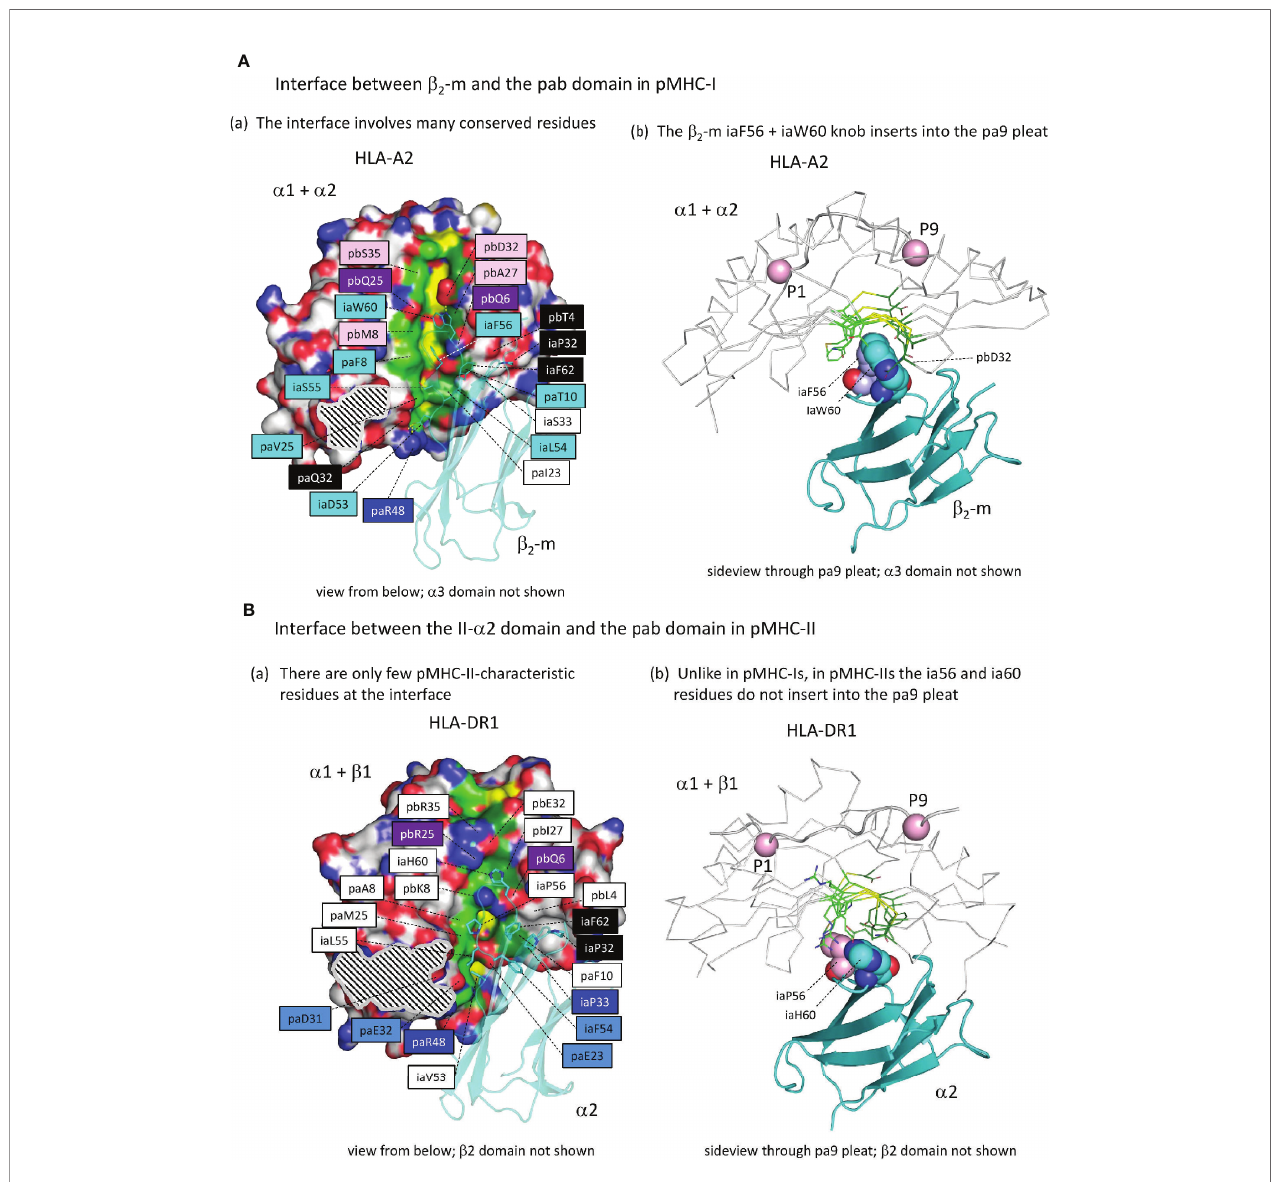
FIGURE 7 | The interface between the ia and pab domains is different between pMHC-I and pMHC-II. ( A a) The pMHC-I structures, here represented by pHLA-A2, have many conserved residues/features at the b 2 -m to a 1 a 2 interface (for a complete list of interface residues see Supplementary Files 2A, B ), especially at the pa9 pleat contact region. Also, a contact patch involving paT10 and pbQ6 (both part of the pa9 pleat) and pbT4 and b 2 -m ia33 (mostly iaP33) and iaF62 is relatively well conserved. Many of the indicated residue names are shaded with non-white colors, which are based on estimated conservation patterns and are also used in Figure 3 and Supplementary File 1A : black, inherited from the MHC homodimer ancestor; dark blue, ancestral to the I- a 1+ b 2 -m/II a lineage; purple, ancestral to the I- a 2+I- a 3/II b lineage; light blue, characteristic for the I- a 1+ b 2 -m lineage; pink, characteristic for the I- a 2+I- a 3 lineage. The a 1 a 2 domain is indicated in surface format with only yellow for pa9 pleat top ridge residues (the ability to see them in this fi gure is evidence of the pleat being open) and element coloring for the other a 1 a 2 domain residues with red, blue, and gold for O, N, and S atoms, respectively, dark and light green for the C atoms of the pa9 pleat pa8 and pa10 lower ridge residues, respectively, and white for the other C atoms. The b 2 -m domain is shown in cyan transparent cartoon format with sidechains of highlighted residues in element color sticks format. The black and white striped region is the a 1 a 2 domain with a 3 domain contact region. Residue pbS35 does not directly contact b 2 -m but pa(A/S/T)45 is a conserved part of the constellation. (A b) The b 2 -m iaF56 + iaW60 residues (shown in individual, element color spheres format) insert into the pa9 pleat, which can easily be seen from this angle with the a 1 a 2 domain [coloring as in (A) ] shown in ribbon format and the sidechains of the pa9 pleat pa8 and pa10 lower ridges in sticks format. The peptide ligand is shown in cartoon format with the C a ’ s of P1 and P9 as pink spheres. ( B a) Similar fi gure as ( A a), but with pHLA-DR1 as a representative structure for pMHC-II. For interactions between the a 1 b 1 and a 2 domains, also see Supplementary Files 2A, B . Coloring of residue names is based on conservation patterns as also done in Figure 3 and Supplementary File 1A , and is similar as done in ( A a) except that MHC-II a -characteristic residues are colored non-dark blue. ( B b) is as ( A b), but showing pHLA-DR1 as a representative pMHC-II structure. The fi gures A a-to- B b show that only in pMHC-I the ia56+ia60 residues penetrate into the pa9 pleat of the pab